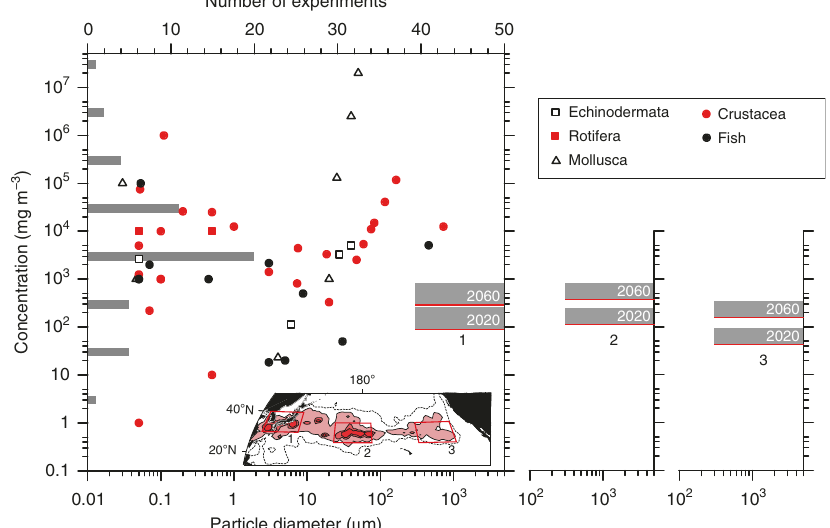
Fig. 9 Comparison between laboratory-based studies and model. Different marks were used for different classes in the biological classi fi cation as shown in the upper right. The 49 experiments listed in Table S1 of de Sá et al. 48 were chosen for this comparison because they reported the weight concentrations of plastic beads in surrounding water to which aquatic biota were exposed. The diameters of plastic beads used for the experiment (lower abscissa) were plotted against the weight concentrations (ordinate). The diameters and minimal weight concentrations that were found to be harmful to organisms in the experiments are plotted, as well as the lower limit of the tested concentrations. When experiments included a range of particle diameters, we used the median value. Gray bars on the left-hand side represent the numbers of experiments by orders of magnitude of the weight concentration (upper abscissa). Red lines indicate modeled weight concentrations averaged over the boxes 1, 2, and 3 in 2020 and 2060; see the inset map for the positions of these boxes and weight concentrations of surface microplastics in August 2066. The height of the gray stippling indicates the average plus one standard deviation. Note that particle diameters in the model ranged from 300 μ m (lower limit among observations) to 5 mm (upper limit of the microplastic de fi drifting in the sea were both assumed to be negligible. The former assumption was was only a minor contribution to the microplastic abundance in the present model. justi fi ed because the abundance of macroplastic debris littered on beaches increases Therefore, these results are shown separately from those of the model without fi shery- as the land-based mismanaged plastic waste 23 estimated in the same region based emission, in the Supplementary information. increases (Supplementary Fig. 8). The latter assumption was justi fi ed because the Furthermore, we examined delayed emission by which time intervals between degradation of macroplastic debris proceeds more rapidly on beaches than in stranding of macroplastic debris and release of microplastics were given on modeled seawater. This is because exposure to ultraviolet radiation and mechanical erosion beaches. This might be justi fi ed because macroplastic debris is likely to be are minimal when submerged in water 24,54,55 , and also because a combination of fragmentized to microplastics on a timescale of years, although our knowledge on generation of microplastics is very scare. In this additional experiment, numbers of ocean currents and Stokes drift repeatedly returns the plastic fragments onto particle release from all sources were proportion with the abundance of macroplastic beaches until they become microplastics 9 . Therefore, the number of particles debris littered in the past; see the particle release delayed by n years in Supplementary currently released was considered to be proportional to the land-based Fig. 6. This simpli fi cation was justi fi ed because the abundance of macroplastic debris mismanaged plastic waste in each region 23 . The particle counts computed over the littered on beaches increases as the land-based mismanaged plastic waste 23 estimated model domain were subsequently converted to microplastic abundance using the observed abundance as mentioned at the end of the Numerical modeling section. in the same region increases (Supplementary Fig. 8). The computation procedures The number of particles released increased from zero in 1957 to the current except the delayed emission were same as those without the delay. The choices of 1, 5, estimate in 2016, in proportion with the transition of the gross domestic product and 10 years for n in this delayed emission model were ad hoc, and were a minor summed for each of the 12 regions. Under the assumption that no regulation/ contribution to the microplastic abundance in the present model. Therefore, these results are shown separately in the Supplementary information. Ocean currents and Stokes drift in 2015 were incorporated into the particle- tracking model shown below. The microplastic distribution was observed mostly in February, 2016, and was likely to be re fl ected by oceanic motion in the latest year. Ocean-current velocities were provided by the Hybrid Coordinate Ocean Model (HYCOM) 59 analysis product for 2015 computation (https://hycom.org/data/ glbu0pt08/expt-91pt2), with a resolution of 1/12° in both latitude and longitude; detailed descriptions of the model setup, data assimilation, and forcing are available at the HYCOM website. The University of Miami wave model version 1.0.1 60 was used to compute the Stokes drift over the model domain with 0.25° horizontal resolution. The wave model was driven by wind data acquired by the Advanced Scatterometer, with 0.25° resolution in both latitude and longitude 61 . The ETOPO1 62 provided the bottom topography and coastlines in the wave model. The Stokes drift velocity and signi fi cant wave height, both computed in the wave model, were determined once daily during the same period of the HYCOM product. The ocean-current velocities and Stokes drift in 2015, updated once each day, were repeatedly used for the computation over the course of 110 years, and thus, fl uctuations of the microplastic distribution due to year-to-year variations in oceanic motion were neglected in the present study. For comparison, the HYCOM reanalysis product for 2010 (https://hycom.org/data/glbu0pt08/expt-19pt1; currently available from 2012) and Stokes drift computed using Advanced Scatterometer wind data for 2010 were used to examine the in fl uence of interannual and decadal variation in surface currents on microplastic distribution. The year 2010 was chosen because the indices for El Ninõ and Paci fi c Decadal Oscillation, the most active interannual and decadal variations in the Paci fi c Ocean, were in the opposite phase to those in 2015 (Supplementary Fig. 4).